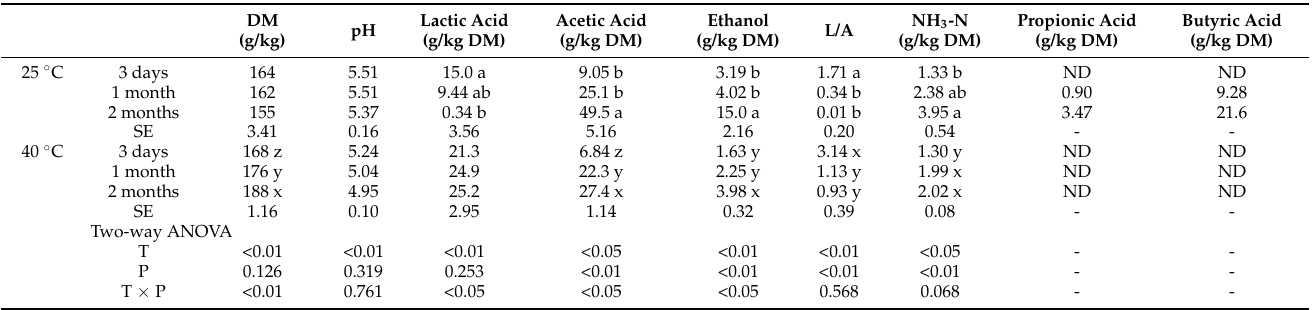
Table 1. Dry matter, pH value, and fermentation products of direct-cut guinea grass silage stored at 25 and 40 ◦ C for 3 days, 1 month, and 2